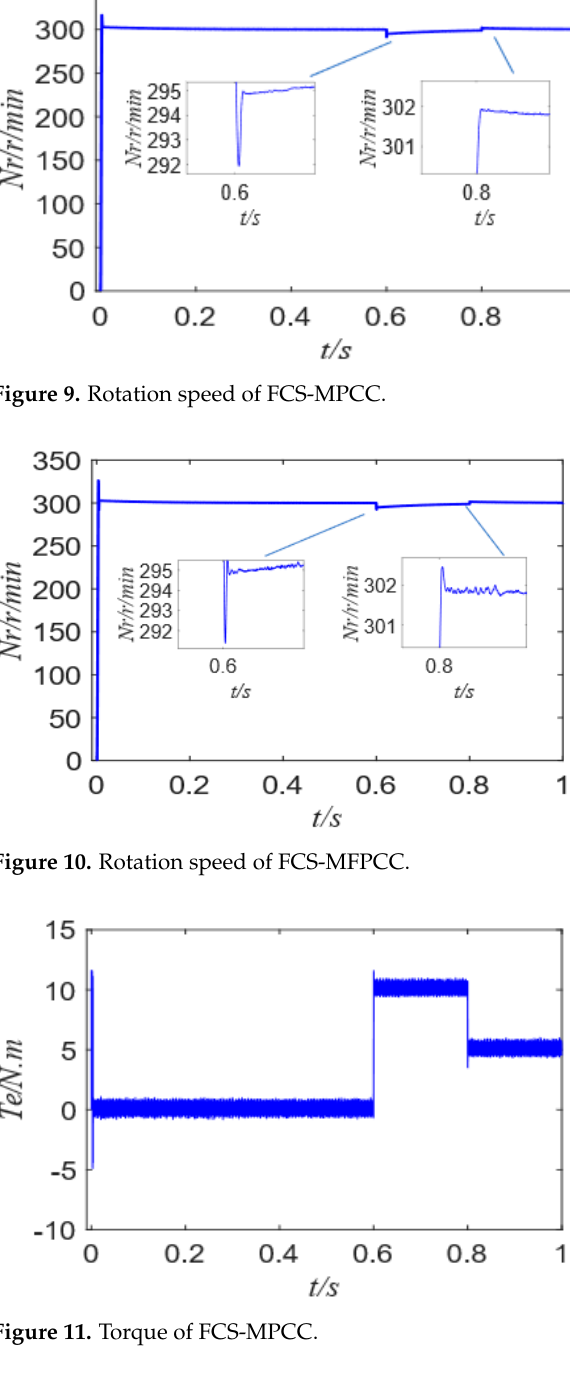
Figure 12. Torque of FCS-MFPCC.